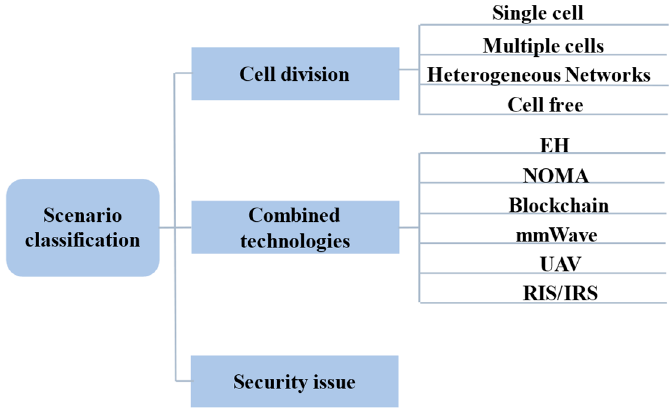
Figure 2. Research scenario classi fi cation.